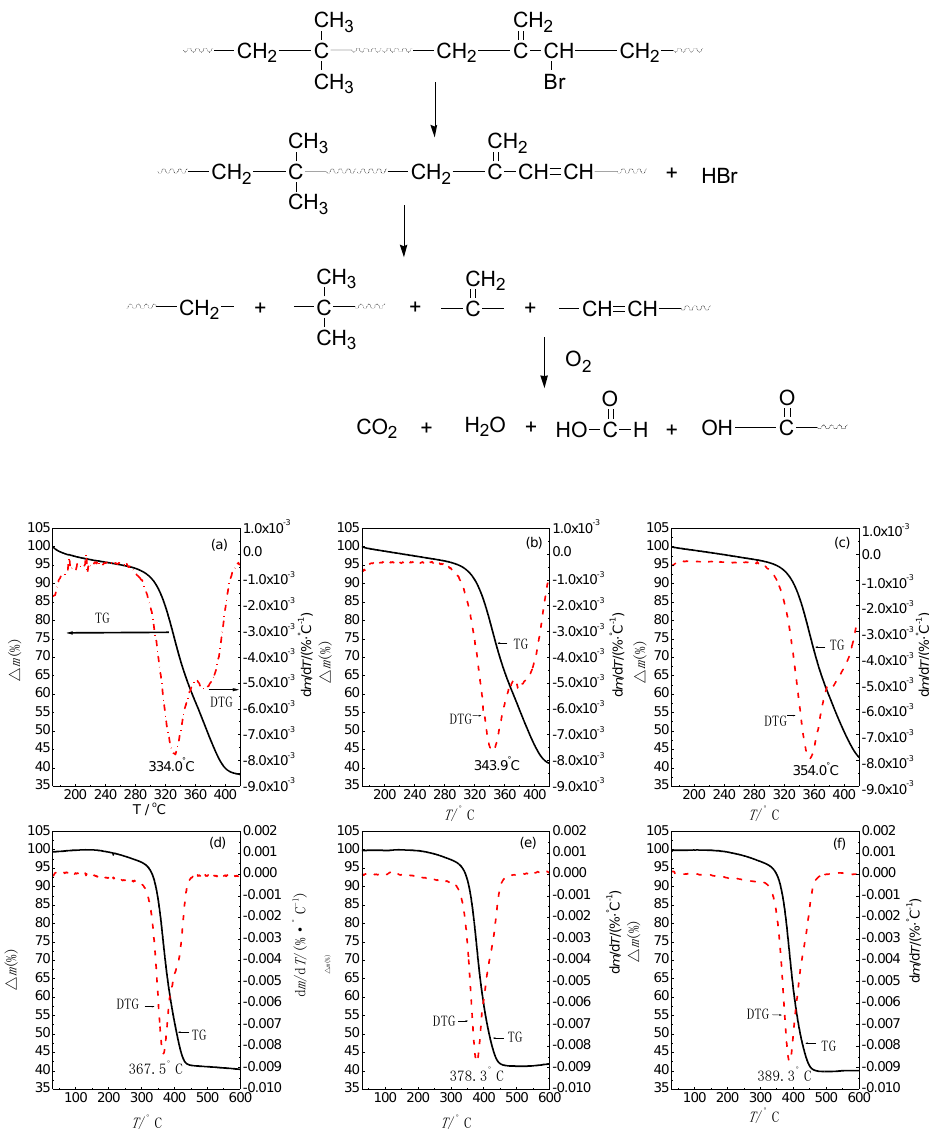
Table 2. Bond energies in BIIR.